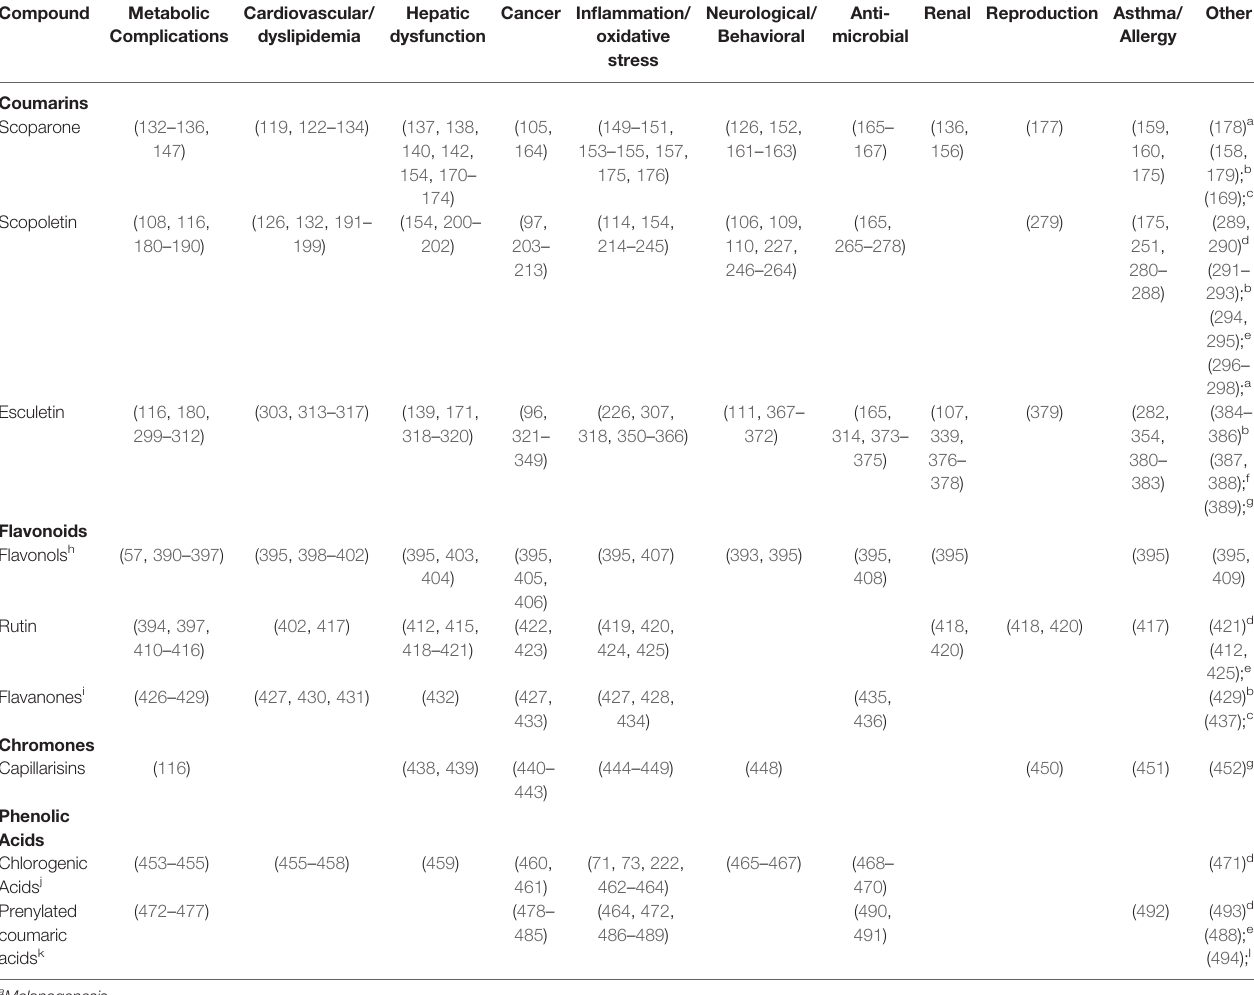
TABLE 3 | In vitro and in vivo effects of bioactive compounds found in A. scoparia